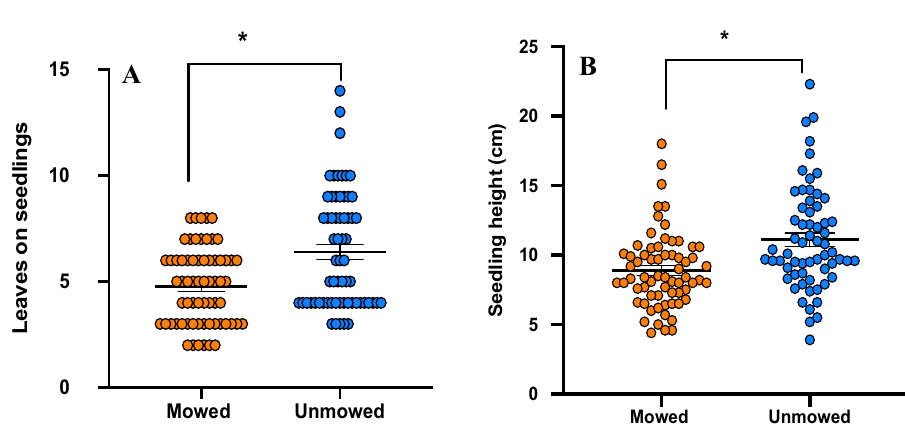
Figure 3. Results of seedlings health and vigor ( A ) number of leaves on seedlings on mowed and unmowed plants (P < 0.001), ( B ) seedling height (cm) on both treatments (P < 0.001) mowed (orange) and unmowed (blue) plants. Means are shown by scale bars and asterisk denotes significantly different results at P < 0.05, while ns denotes non-significant results.